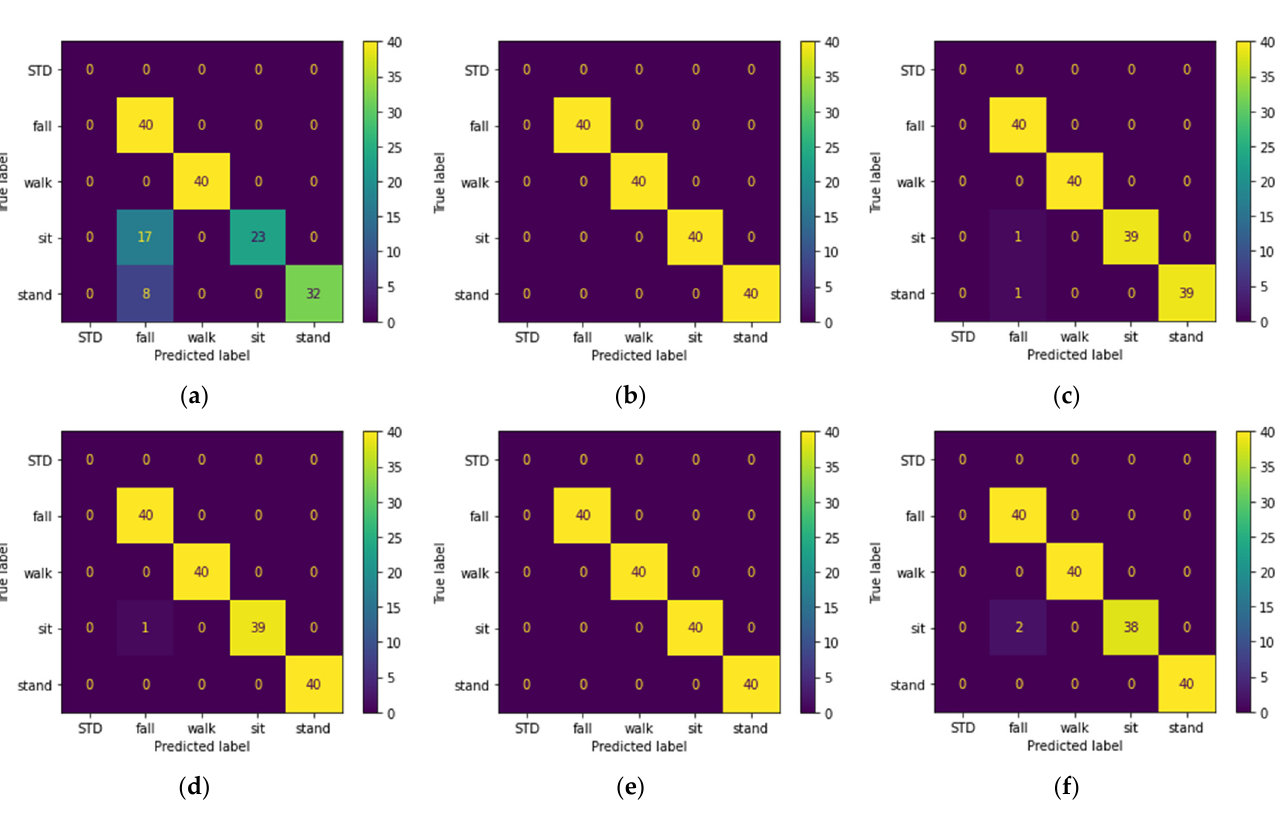
Figure 7. Confusion matrix of the activities in the unseen dataset predicted using: ( a ) MLP; ( b ) SVM; ( c ) Random Forest; ( d ) ERT; ( e ) KNN; ( f ) GTB; classifiers trained with top PCA components extracted from hybrid Doppler–Mel-spectrogram features of the train dataset.